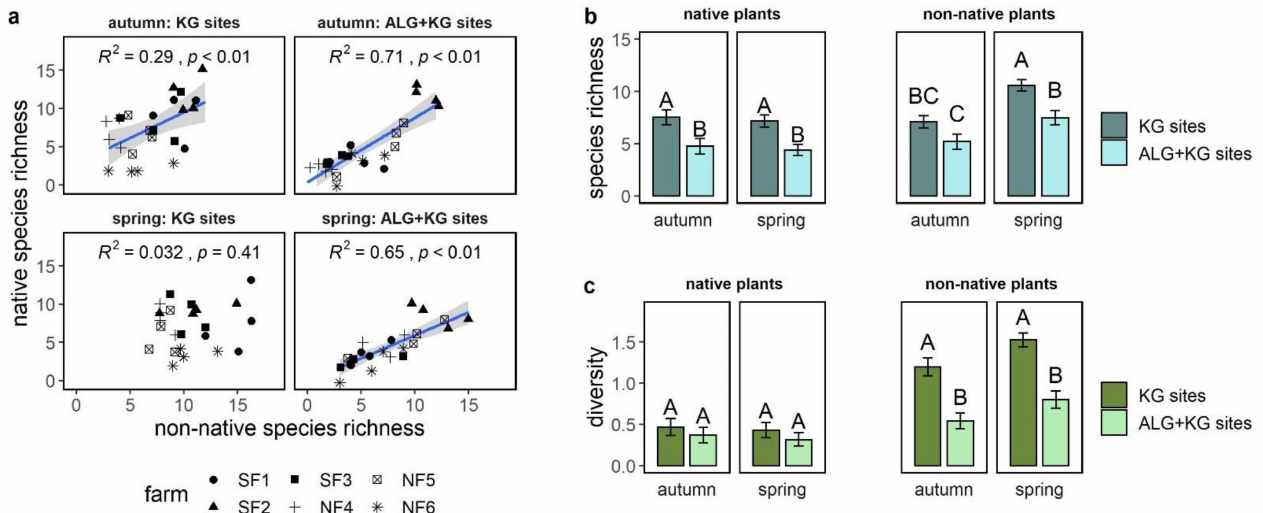
Figure 2. ( a ) Correlation among mean native and mean non-native species richness per plot for each site type and season, including Pearson correlation coefficient (R 2 ) and p -value. ( b ) Direct comparison of mean native and mean non-native species richness, and ( c ) the same for Shannon diversity per plot for KG (darker colour), ALG+KG (lighter colour) sites in autumn and spring. Different capital letters indicate significant ( p < 0.05) differences among the compared groups and error bars represent the standard error of the